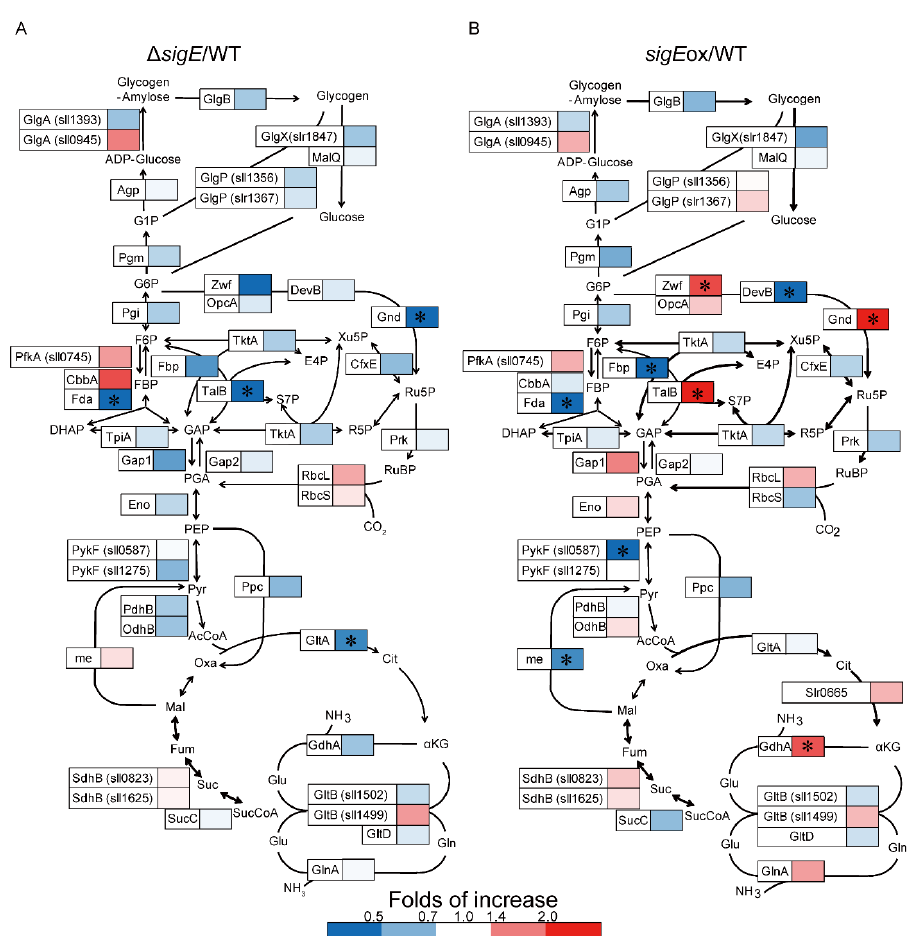
Figure 2. Effect of sigE deletion and overexpression on the expression of the central metabolism proteins of Synechocystis sp. PCC 6803. Relative expression levels [Δ sigE /WT ( A ) and sigE ox/WT ( B )] of proteins determined by the targeted proteome analysis are represented by heat maps. Asterisks indicate a significant difference in terms of both two-sided Student’s t -test ( α 0.05) and the fold increase (>1.5 and <0.67).